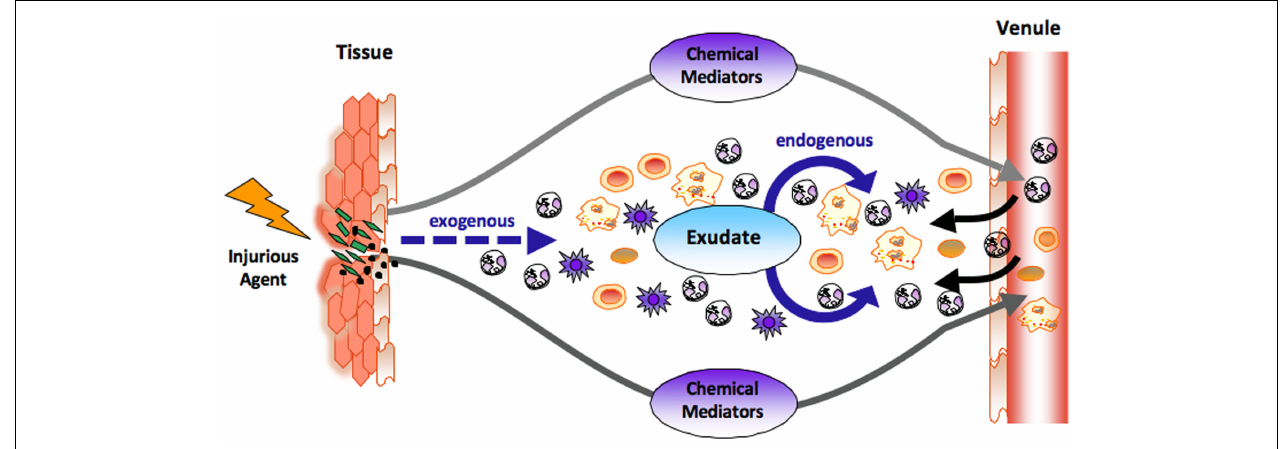
recruitment of neutrophils (PMNs) to form inflammatory exudate. Novel chemical mediators are produced in the evolution and resolution of the exudate that regulate tissue responses (see text for details).The black arrow denotes leukocyte traffic from venules and the dashed arrow denotes exogenous, i.e., bacterial components and chemoattractants.